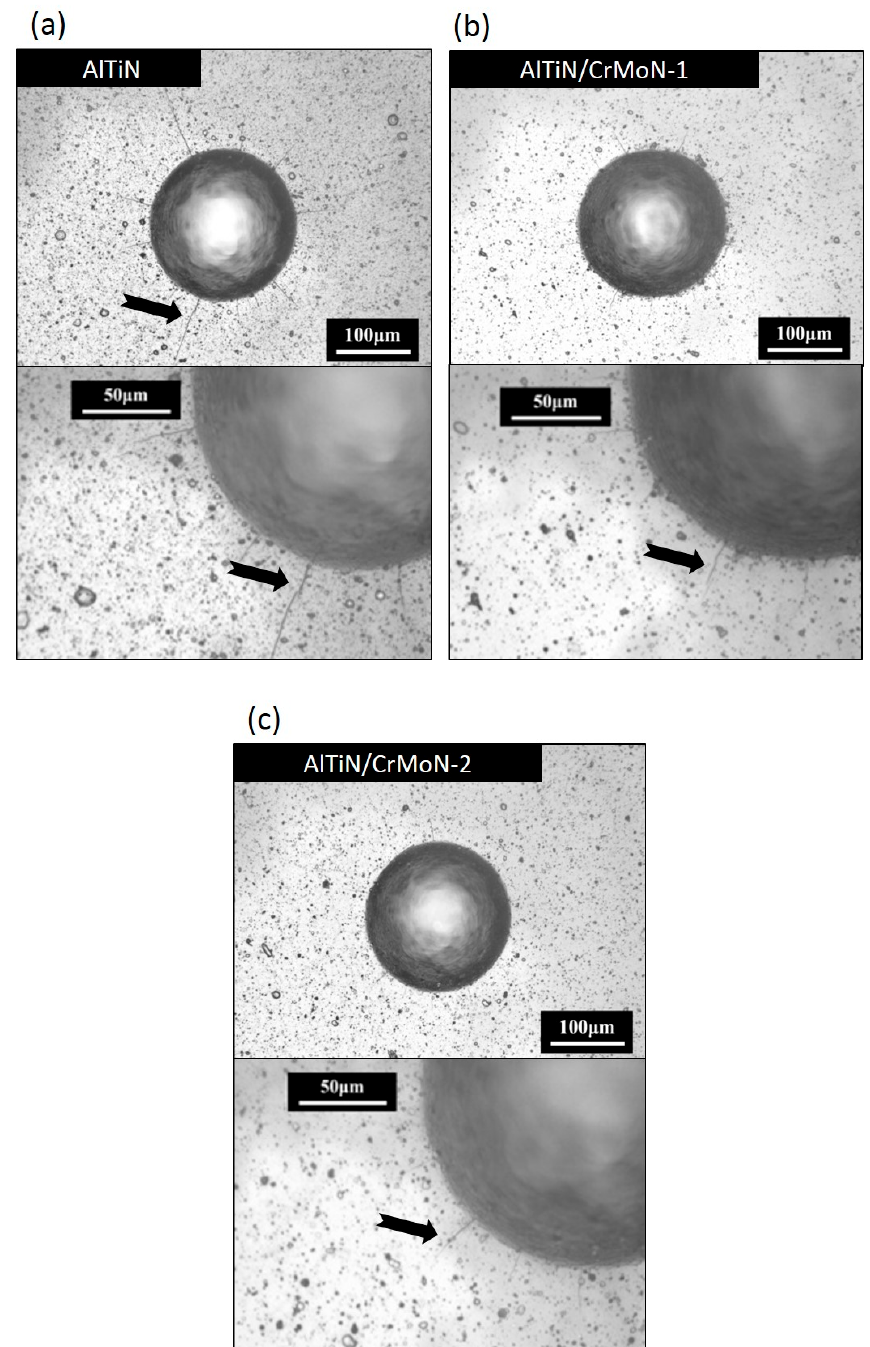
Figure 5. Optical images of the indentation crater of the ( a ) AlTiN, ( b ) AlTiCrMoN-1 and ( c ) AlTiCrMoN-2 coated samples after Rockwell indentation. Arrows indicate the radial cracks.